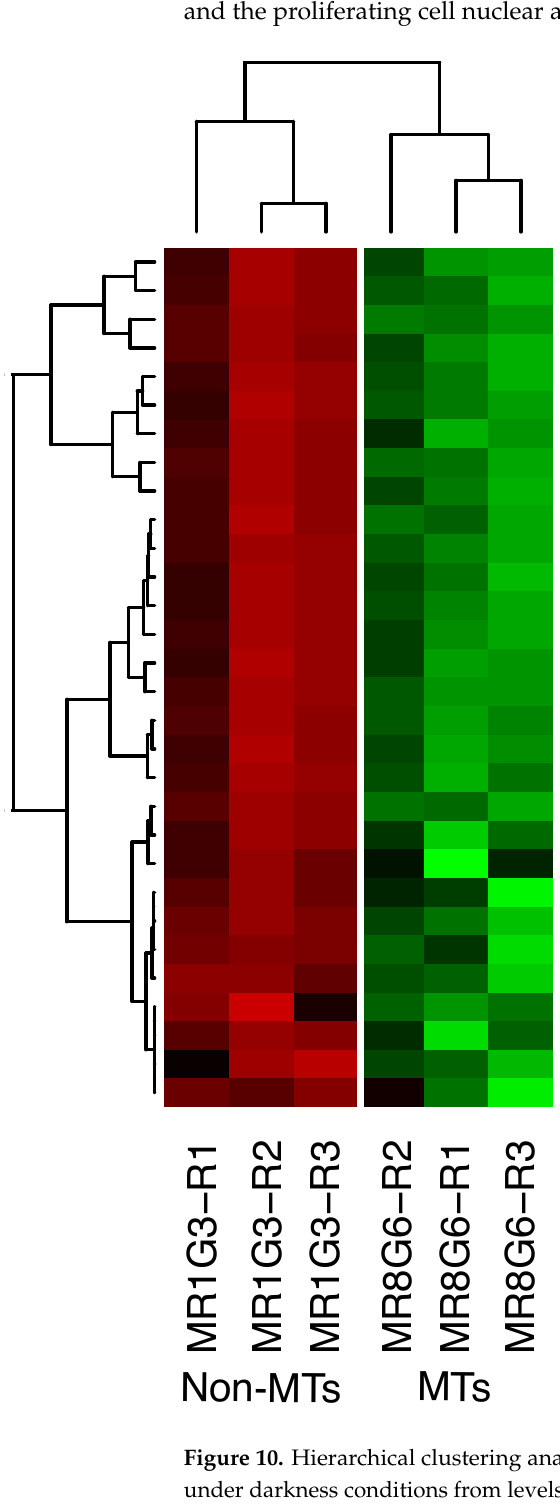
Figure 10. Hierarchical clustering analyses (HCA) and heat map of RPs during MTs development under darkness conditions from levels of up-regulation are present in